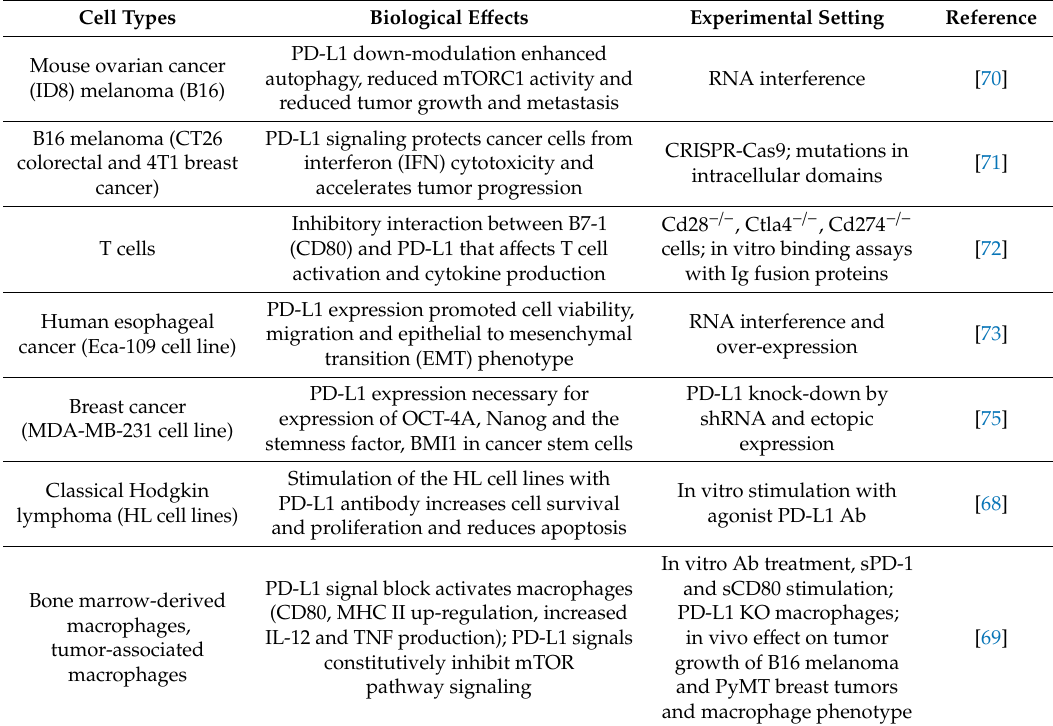
Table 1. Evidence of PD-L1 reverse